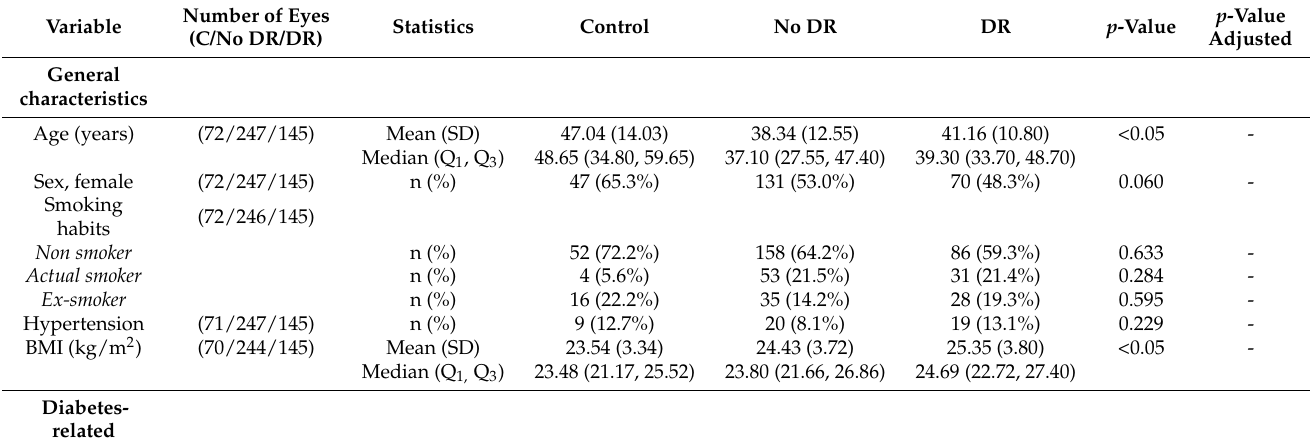
Table 1. Demographics and clinical characteristics of study eyes. (* pairwise comparison: No DR vs. DR; p -value adjusted by age, sex, scan quality, diabetes mellitus duration and axial length. DR = Diabetic retinopathy, DM = Diabetes mellitus, BMI = Body mass index, SD = Standard deviation, OCT = Optical coherence tomography, OCTA = Optical coherence tomography angiography, FAZ = Foveal avascular